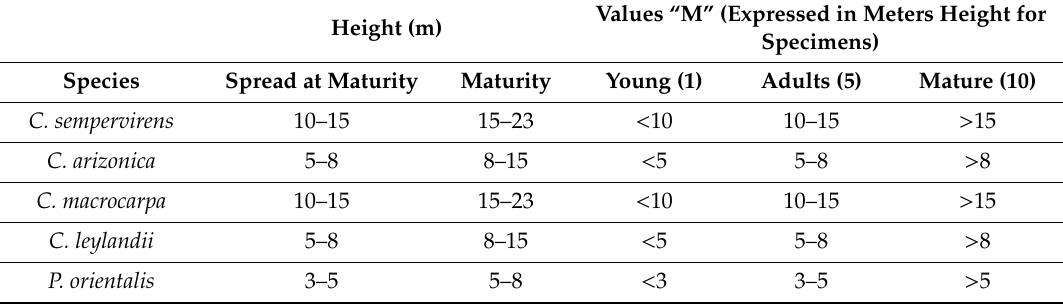
Table 3. Height at which the studied species begin to mature and height when they reach the maturity [42] and values of the “M” parameter of our index according to the heights. Values “M” (Expressed in Meters Height for Height (m) Specimens) Species Spread at Maturity Maturity Young (1) Adults (5) Mature (10) 10–15